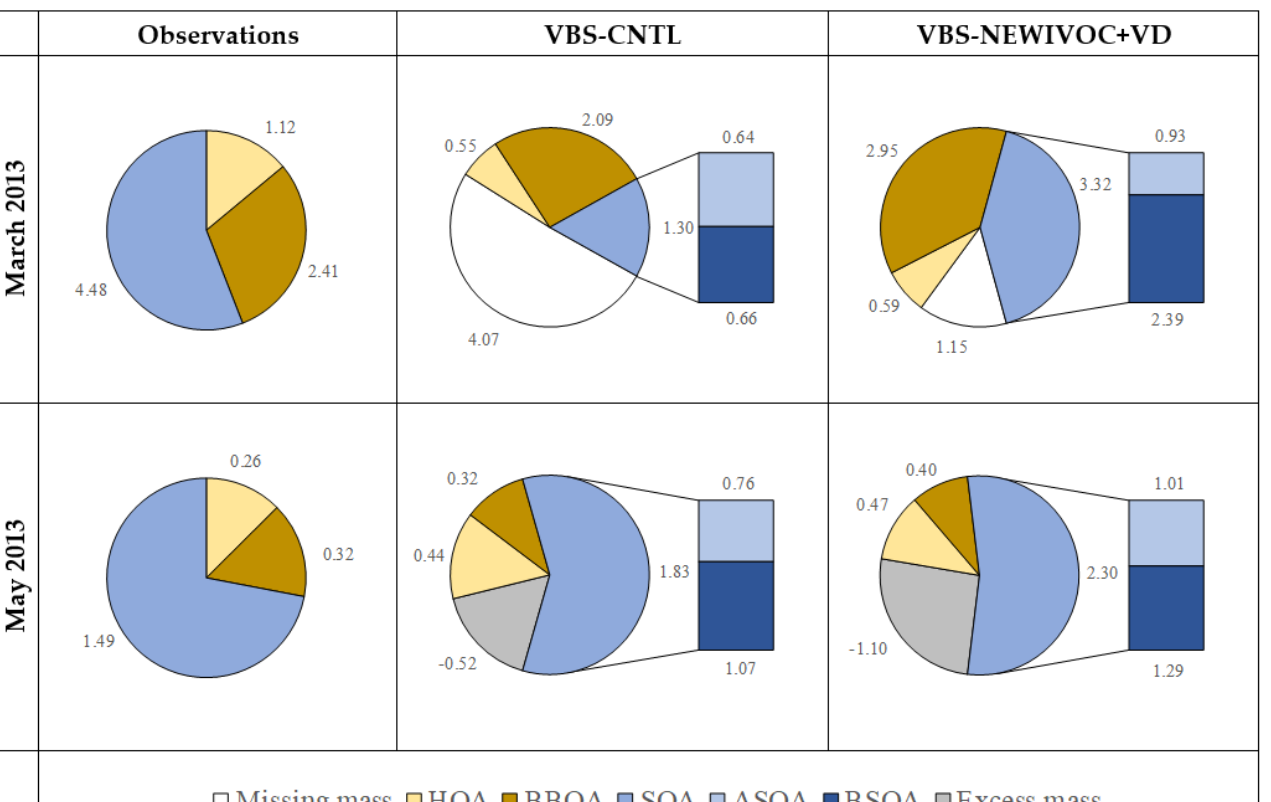
Figure 17. OA average composition (µg m −3 ) for March 2013 and May 2013 at Bologna: observations (PMF results), VBS-CNTL simulation, VBS-NEWIVOC+VD simulation. ASOA = anthropogenic SOA; BSOA = biogenic SOA, SOA from anthropogenic biomass combustion and from biogenic emis- sions.